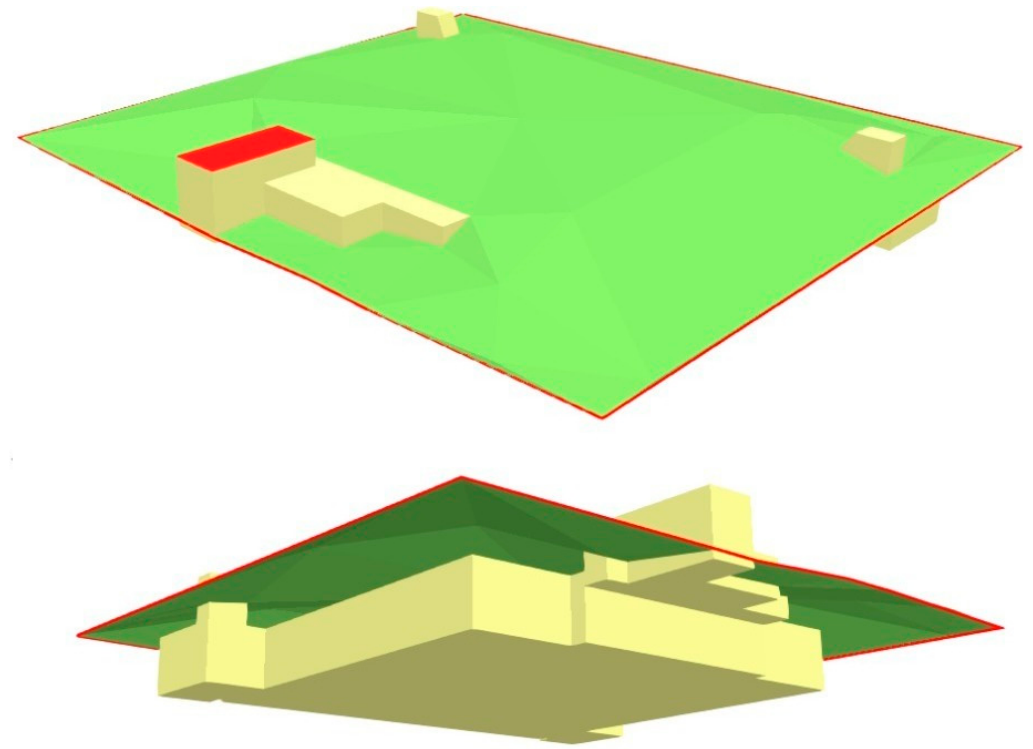
Figure 9. The underground shelter viewed above and below the surface of the terrain .